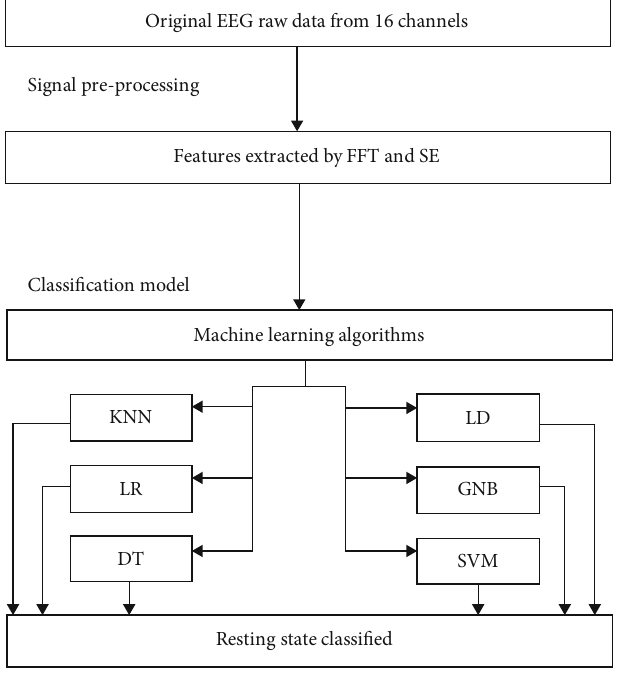
Figure 9: Sequential steps of our study. Table 2: Classi fi cation accuracies of classi fi ers applied to extracted features by